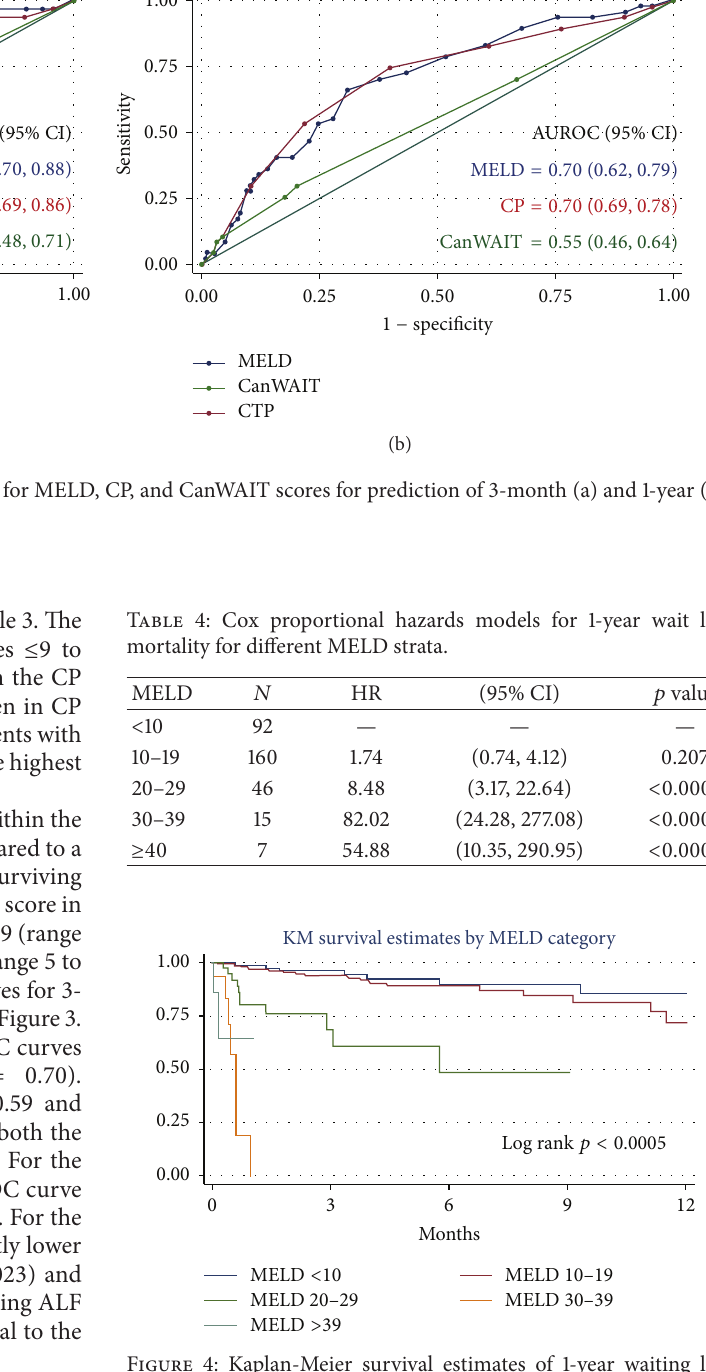
Figure 4: Kaplan-Meier survival estimates of 1-year waiting list survival for different strata of MELD